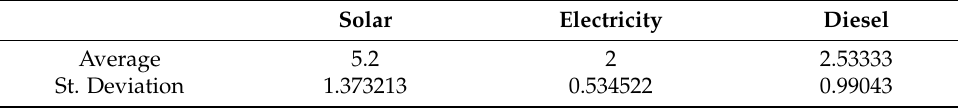
Table 4. PBP of different power sources for